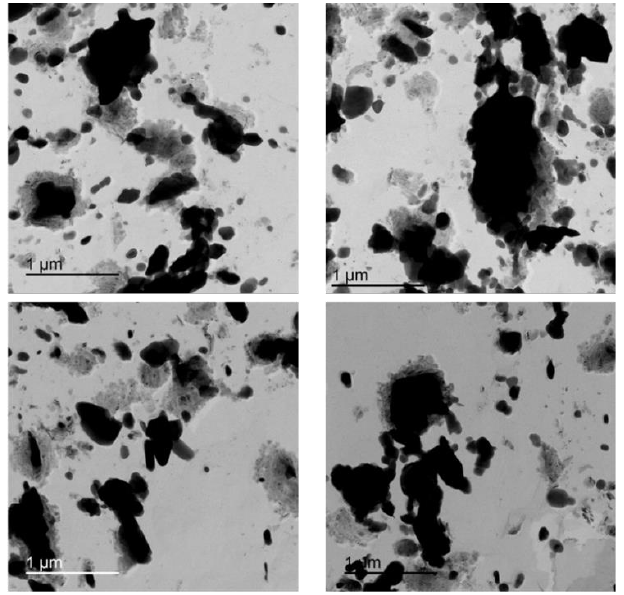
Figure A14. Failed crept cross-weld specimen 92-HAZ-6-6 650 °C 65 MPa 3877 h (sample H). TEM images on a carbon extraction replica at 50,000X.